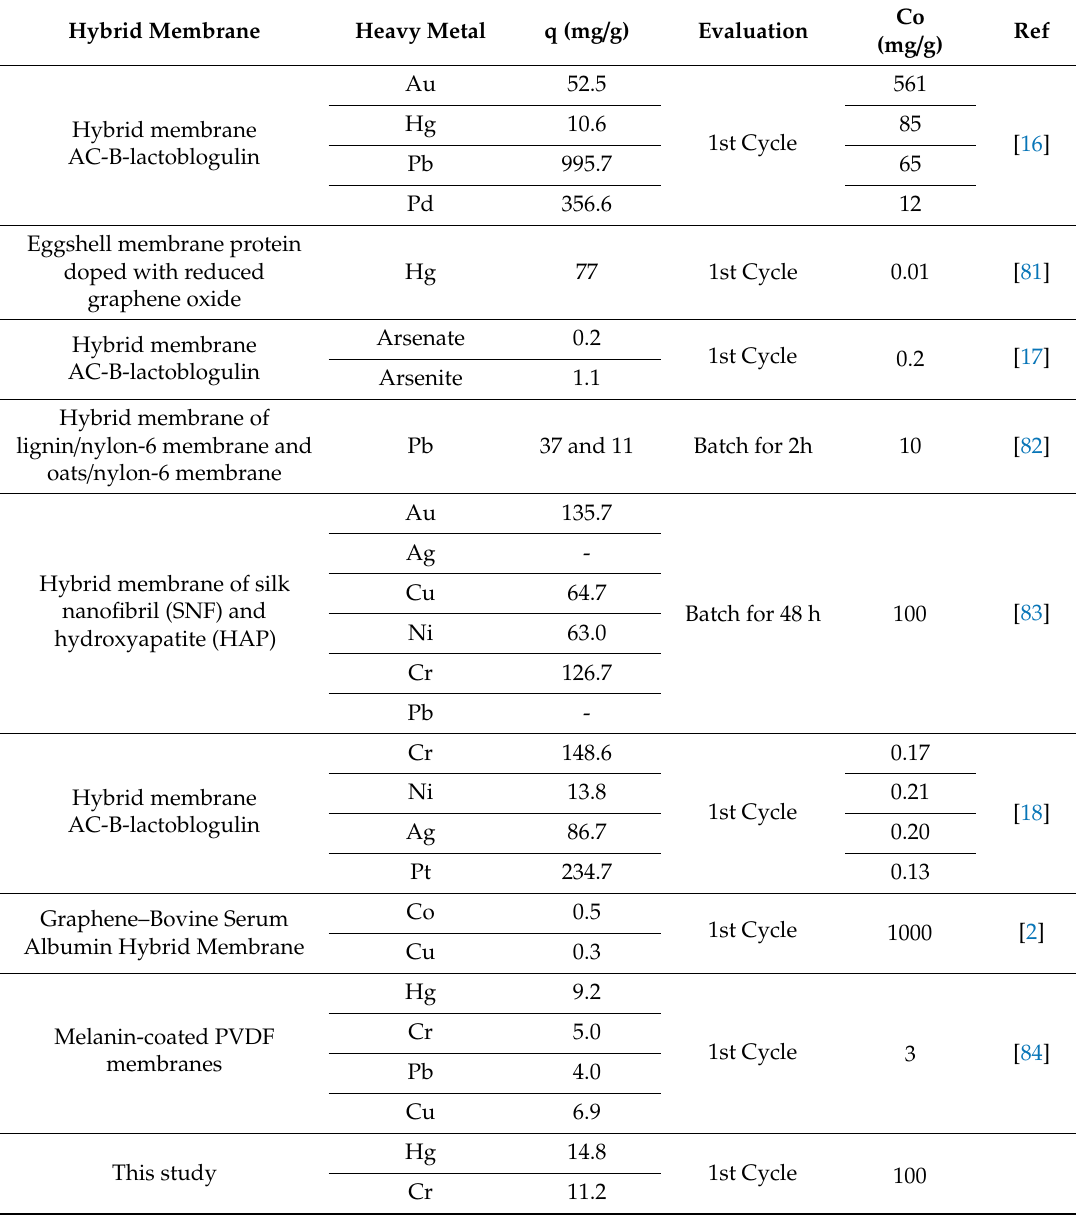
Table 4. Metal adsorption capacity of some bio-based hybrid membranes reported in